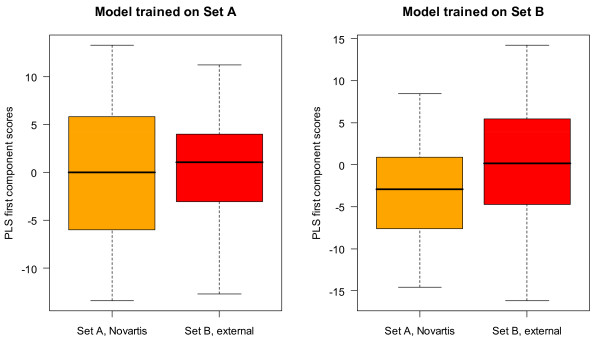
Extrapolation from one aryl-amine data set to another: cross-set Tukey Boxplot of the distribution of scores. Distribution of scores obtained for Set A (orange box) and Set B (red box) when applying a model trained on all of the data in Set A (left) or a model trained on all of the data in Set B (right) as a measure of outliers and domain.